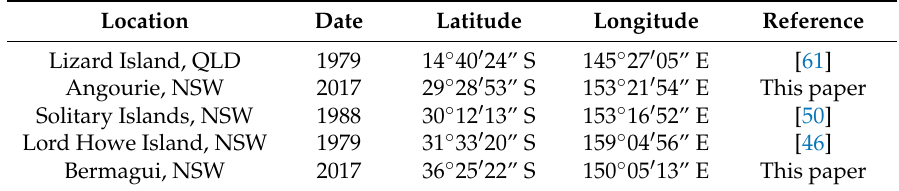
Table 2. Distribution records of Mariaglaja tsurugensis from eastern